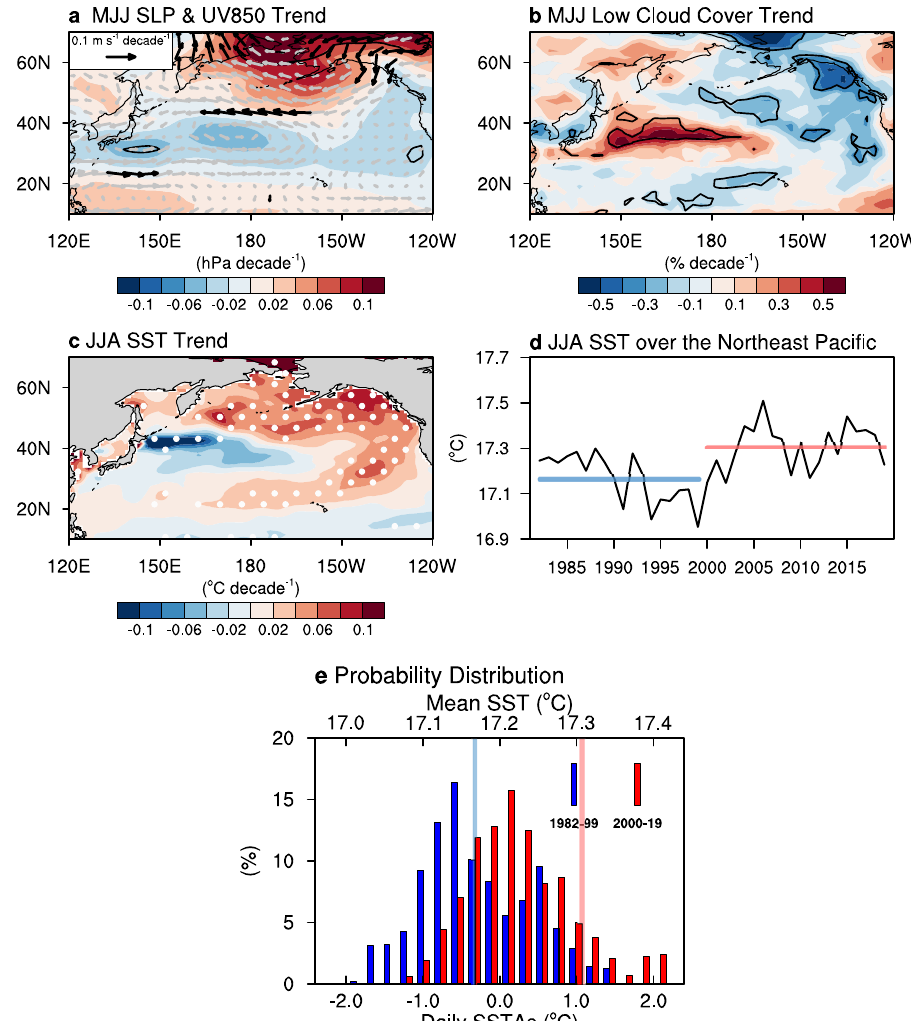
Fig. 4 Trends of atmospheric circulation, low-level cloud cover, SSTs and the probability distribution of daily SST simulated in ART_Exp. Trend map of a SLP (hPa decade − 1 ) and 850-hPa winds (m s − 1 decade − 1 ), b LCC (% decade − 1 ) during MJJ and c SST (°C decade − 1 ) during JJA for 1982 – 2019. Black contour, vector and stippling regions in a – c indicate statistically signi fi cant values at the 90% con fi dence level based on a two-sided t test (all other vectors are shown in gray). d Time series of mean SST (°C, black line) during JJA in the Northeast Paci fi c. The light blue and red line in d denotes the mean SST values for 1982 – 1999 and 2000 – 2019, respectively. e Probability distribution of daily SSTAs (°C on lower x -axis) in the Northeast Paci fi c during JJA for 1982 – 1999 (blue bar) and 2000 – 2019 (red bar) with their mean SST (°C on upper x